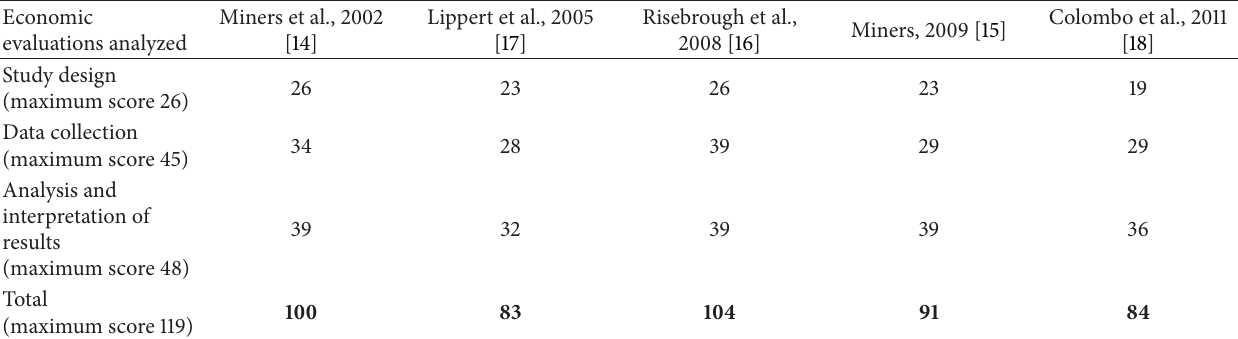
Table 2: Results of the quality assessment with scores ∗